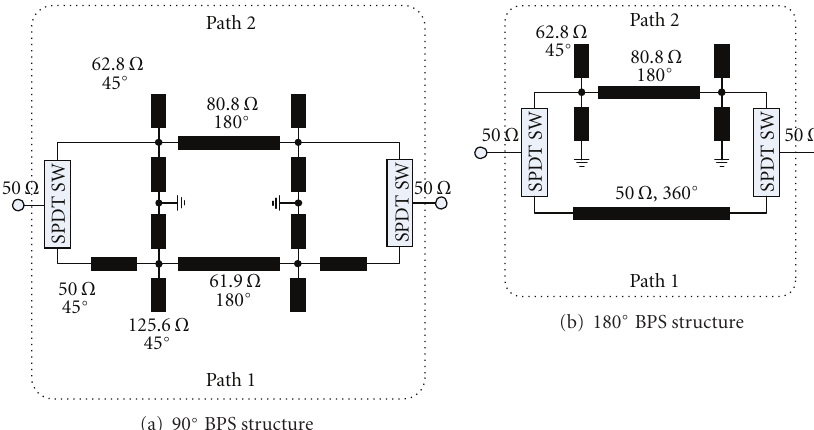
Figure 5: Broadband 90 ◦ /180 ◦ phase shifter structures.